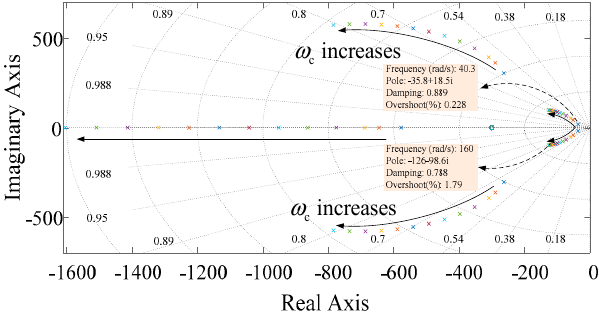
Figure 8. Pole-zero map of N represents zero points; the same below).